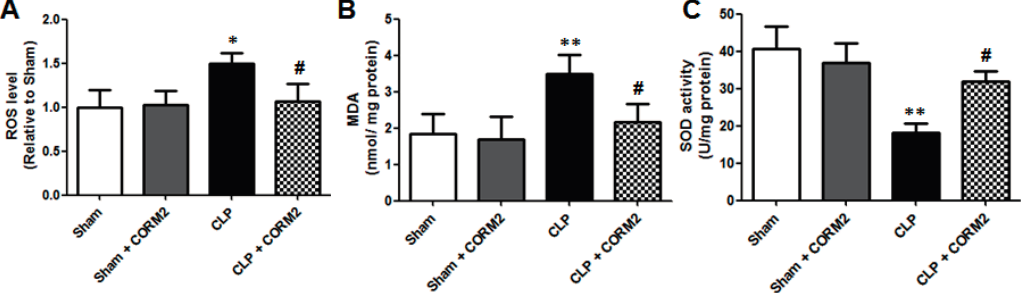
Figure 4. Carbon monoxide significantly decreased oxidative damage in renal tissues of septic rats. ( A ) CORM-2 treatment decreased CLP-induced ROS levels in renal tissues of septic rats; ( B ) CORM-2 treatment decreased CLP-induced MDA levels in renal tissues of septic rats; ( C ) CORM-2 treatment increased SOD activity in renal tissues of CLP-induced septic rats; CORM-2 had no effect on oxidative damage in renal tissues to normal rats (Sham). Results are presented as mean ± SD, n = 6 rats per group. * p < 0.05, ** p < 0.01 vs. sham group and # p < 0.05 vs. CLP group.